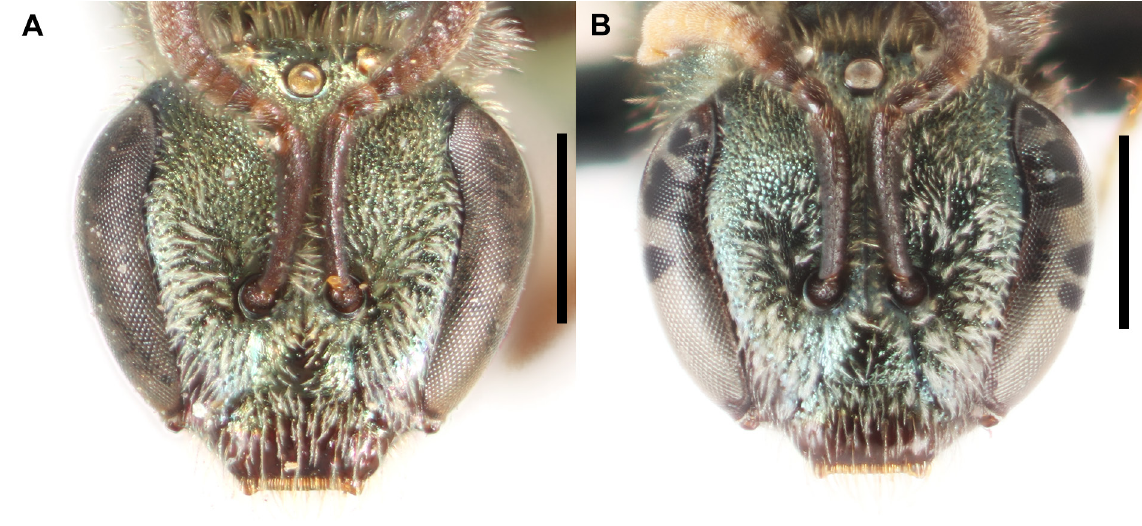
Fig. 89. Face. A . Lasioglossum pseudotegulare (Cockerell, 1896), ♀, slightly longer. B . L. stictaspis (Sandhouse, 1923), ♀, slightly shorter. Scale bars = 0.5